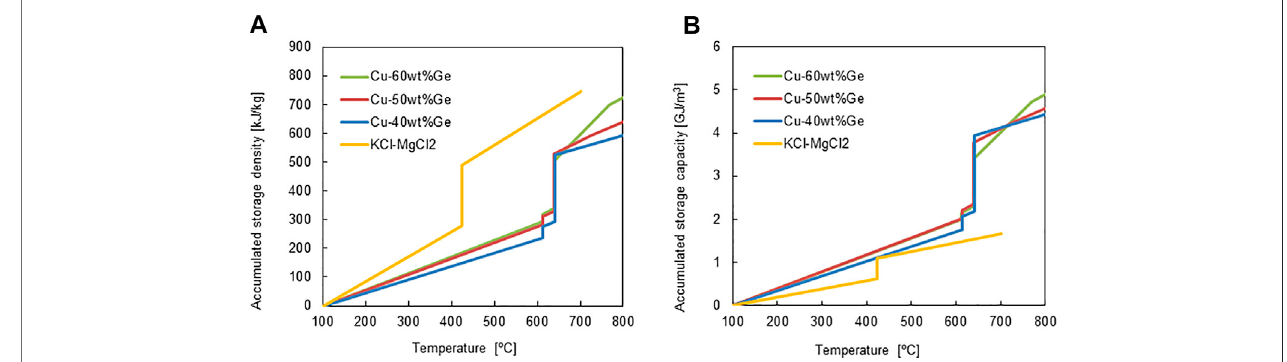
FIGURE 6 | (A) accumulated thermal storage density and (B) accumulated thermal storage capacity for all the alloys and chloride molten salt.